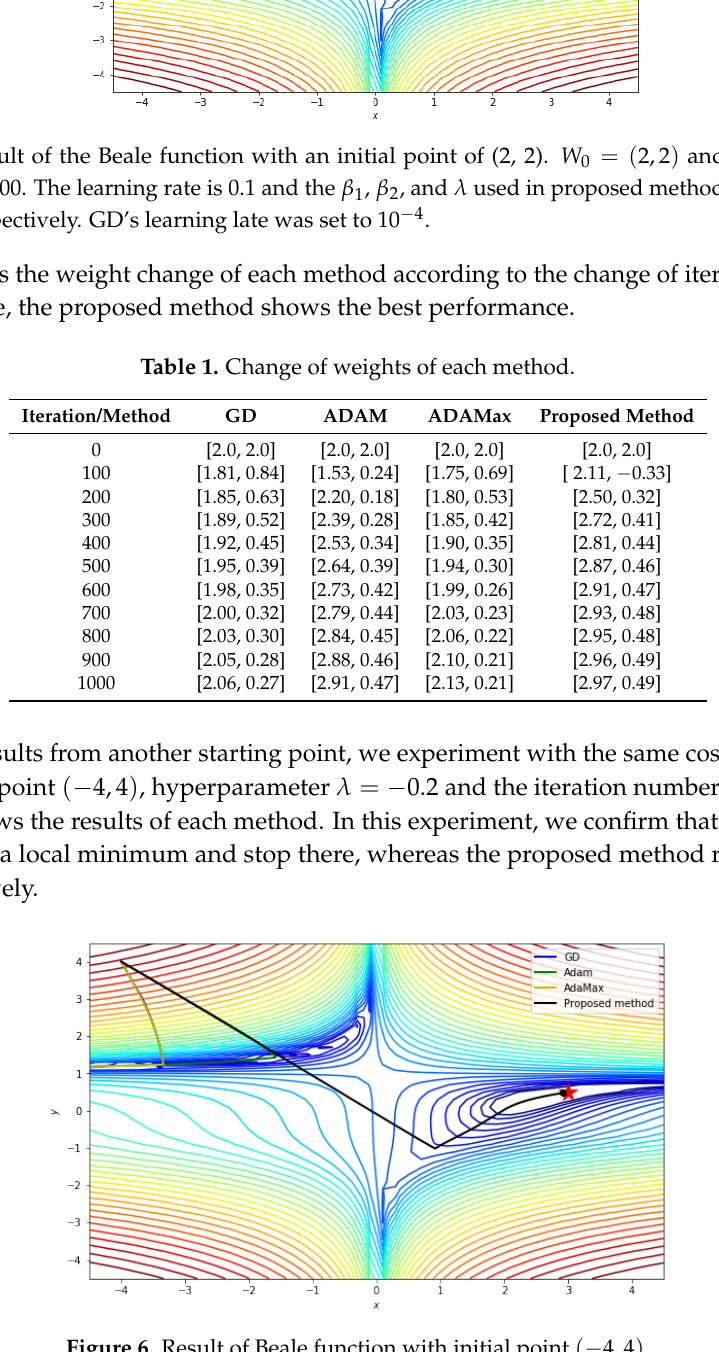
Figure 6. Result of Beale function with initial point ( − 4,4 )